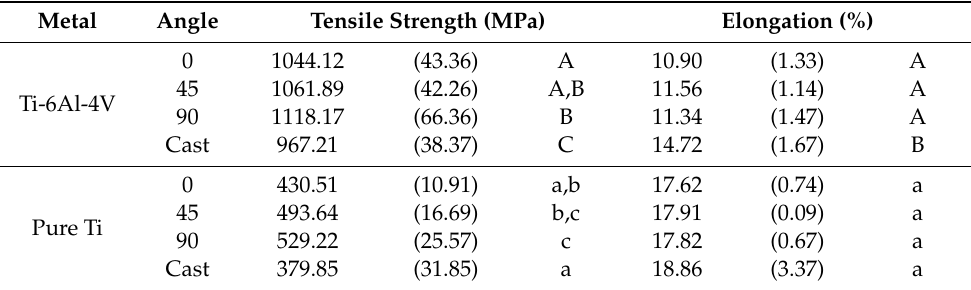
Table 2. Tensile strength and